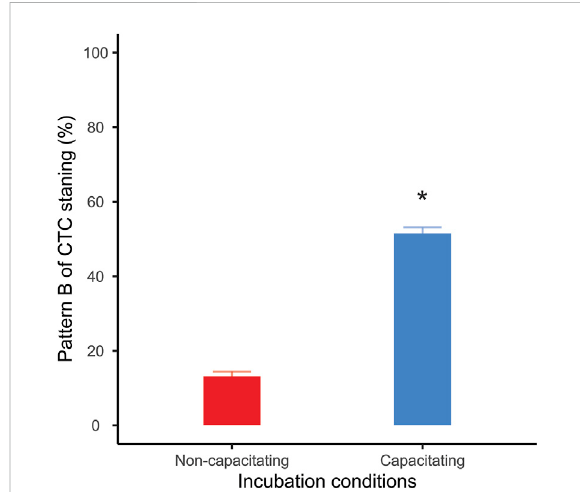
FIGURE 1 Percentage of live capacitated sperm (CTC pattern “ B ” ) after one hour of incubation. Bars correspond to means +standard error. Red bar: sperm incubated in non-capacitating conditions; bluebar:spermincubatedincapacitatingconditions.Asterisk indicates signi fi cant differences ( p < 0.05) in percentages between incubation